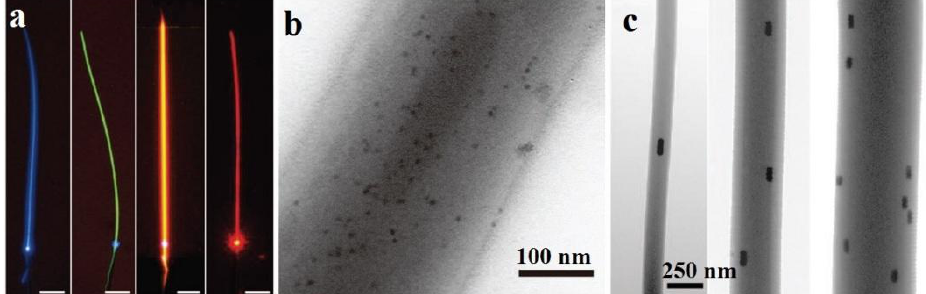
Figure 17. Functionally activated polymer microfibers. ( a ) Typical light-emitting polymer microfibers excited by 355 nm light. The microfibers are doped with different fluorescent dyes to emit different colors of light. Scale bars: 50μm [90]; ( b ) A 280 nm diameter PS microfiber doped with CdSe quantum dots [30]; ( c ) Three PAM nanofibers doped with aligned GNRs